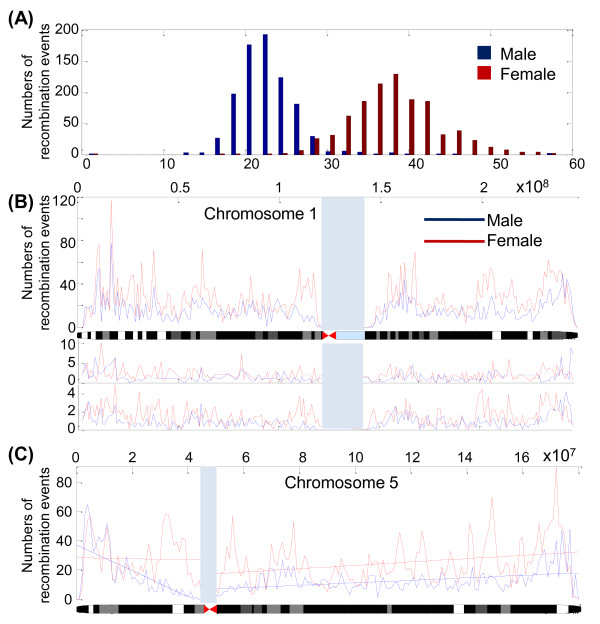
Distribution of the 2,145 paternal and 2,145 maternal recombination events across all human autosomal chromosomes (A), chromosome 1 (B) and chromosome 6 (C). (A) The distribution of the numbers of the paternal (blue bar) and maternal (red bar) recombination events across autosomal chromosomes. (B) The number of recombination sites for chromosome 1 was calculated using a window width of 1 Mb. The middle and lower panel of the Figure 3B are the Marshfield recombination map and Icelandic recombination map, respectively. The maternal (red) and paternal (blue) genetic distance for each 1-Mb window was calculated on the basis of the SNP position information provided by Affymetrix. We assumed a constant crossover rate between two adjacent SNP markers. The physical position and the chromosome ideogram are shown on the top and bottom of the figure, respectively. (C) The regression lines for maternal (red) and paternal (blue) crossover rates corresponding to the distance from the centromere are shown, using chromosome 6 as an example. The slope was significantly different from zero in the p arm of male but not in female chromosomes. In contrast, both genders showed a significant correlation in the number of recombination sites towards the telomere of the q arm. The chromosomal regions without any SNP site in the Affymetrix Genome-Wide Human SNP 6.0 arrays are marked as gray blocks.